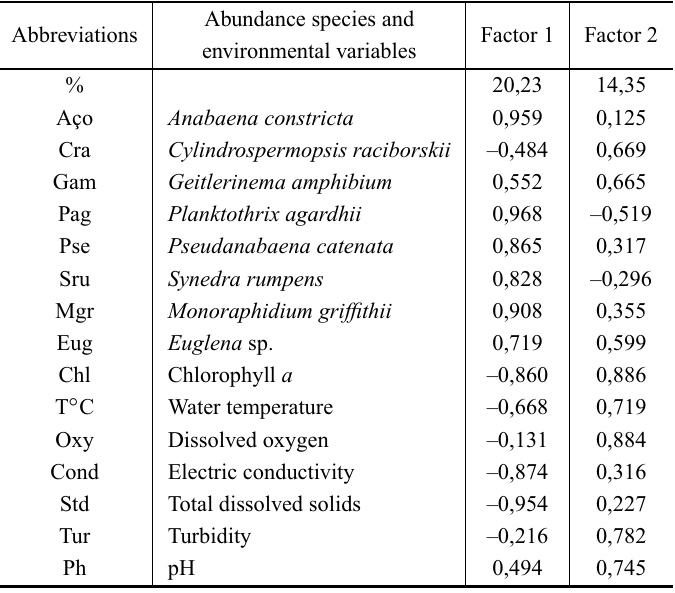
Correlation factors (%) of principal component analysis (PCA) between abundance species and environmental variables in the Carpina reservoir (PE, Brazil) from January to November 2006.